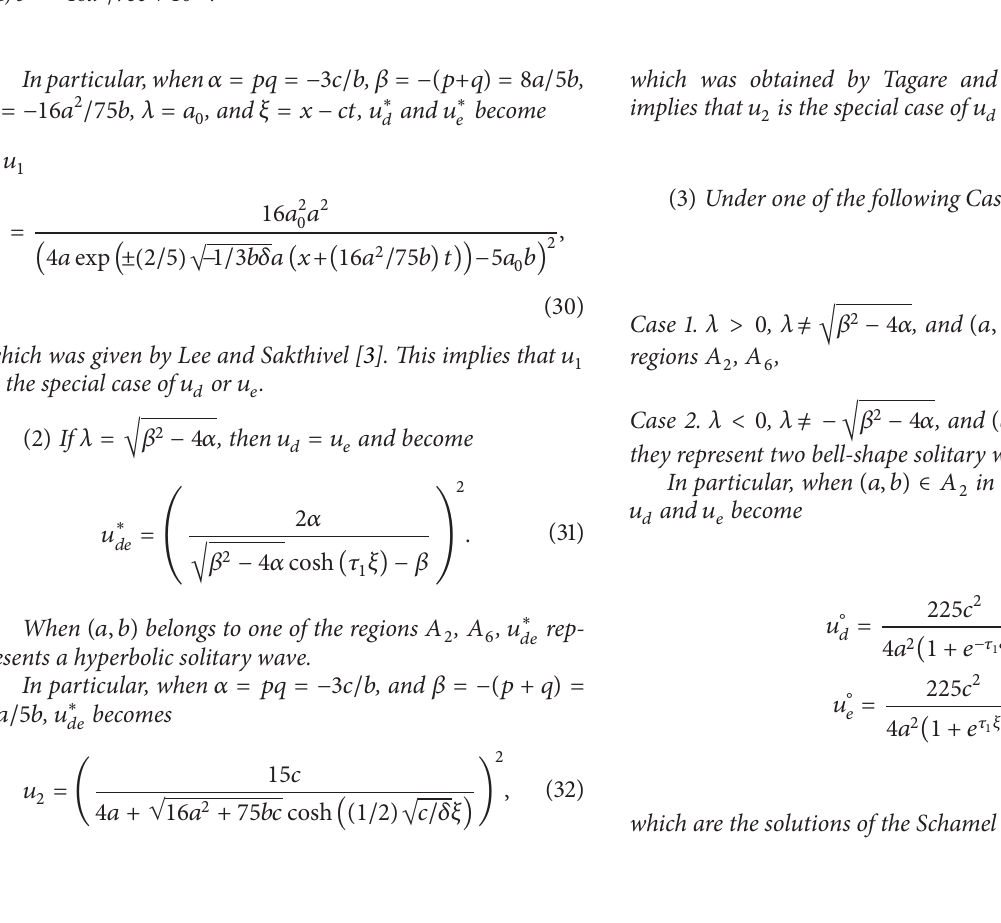
Figure 15: (The antikink wave is bifurcated from the antikink-like wave). The varying process for the graph of 𝑢 − 𝑎 when 𝑐 > 0 , 𝛿 > 0 , 𝑎 > 0 , and 𝑏 → −16𝑎 2 /75𝑐 + 0 , where 𝑐 = 1 , 𝛿 = 1 , 𝑎 = 1/2 , and (a) 𝑏 = −16𝑎 2 /75𝑐 + 10 −3 . (b) 𝑏 = −16𝑎 2 /75𝑐 + 10 −4 . (c) 𝑏 = −16𝑎 2 /75𝑐 + 10 −6 . (d) 𝑏 = −16𝑎 2 /75𝑐 + 10 −8